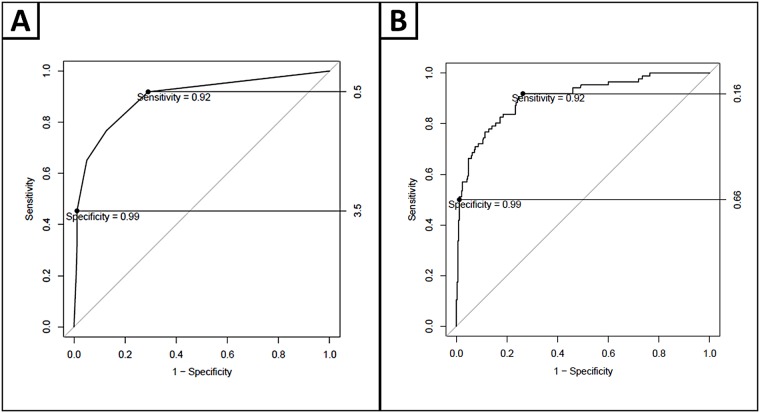
ROC curves displaying DOC mood optimal diagnostic cut-points, for high sensitivity and specificity and diagnostic cut-points with a logistic regression applied, controlling for age, sex and education.